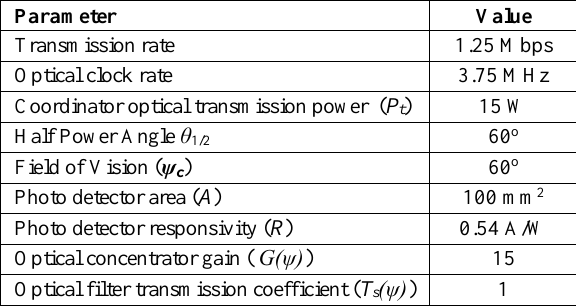
Table 1. PHY layer